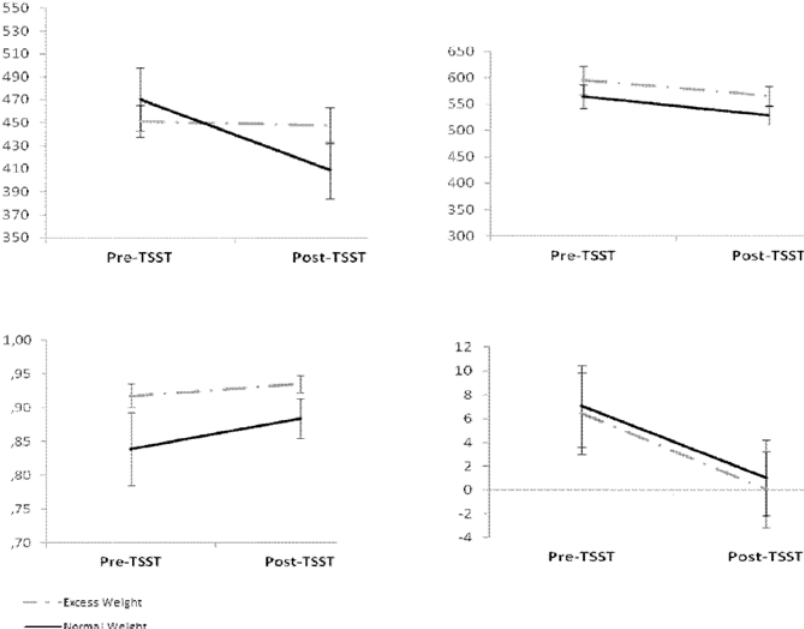
Fig 3. Cognitive performance in adolescents with excess weight and adolescents with normal weight before and after exposure to the Trier Social Stress Task (TSST). Top panel Y axes represent time in milliseconds. The Y axis in the bottom-left panel represents signal detection derived Beta scores, ranging from 0 to 1. The Y axis in the bottom-right panel represents Iowa Gambling Task net scores, ranging from -60 to